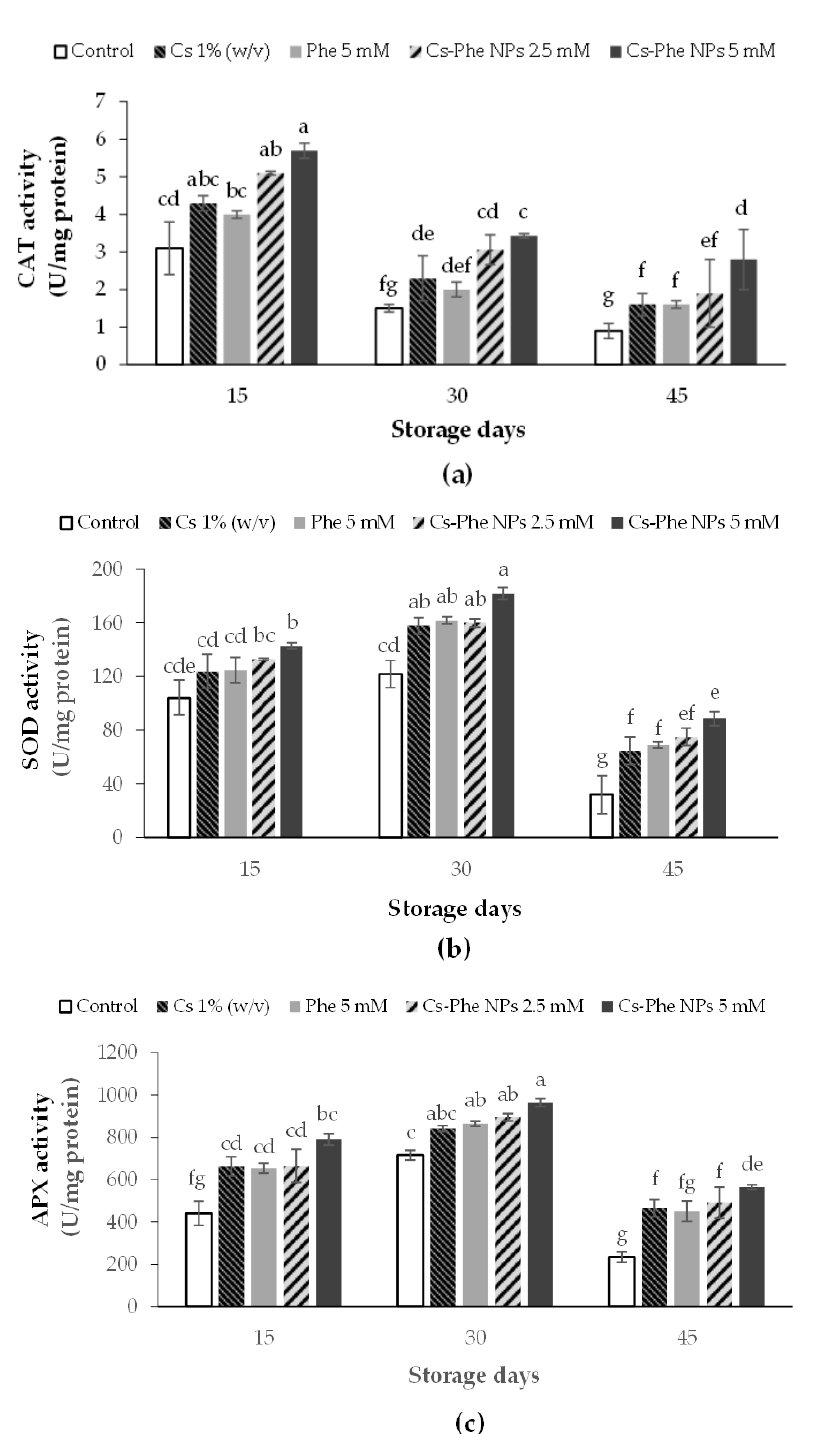
Figure 8. Effects of chitosan, phenylalanine, and chitosan-coated phenylalanine nanoparticles treatments on the CAT ( a ), SOD ( b ), and APX ( c ) activities of persimmon fruit during storage at 4 °C for 15, 30, and 45 days. Each value represents the mean ± standard errors of three replications. Different letters indicate statistical differences using Duncan’s multiple range tests at P < 0.05 level.